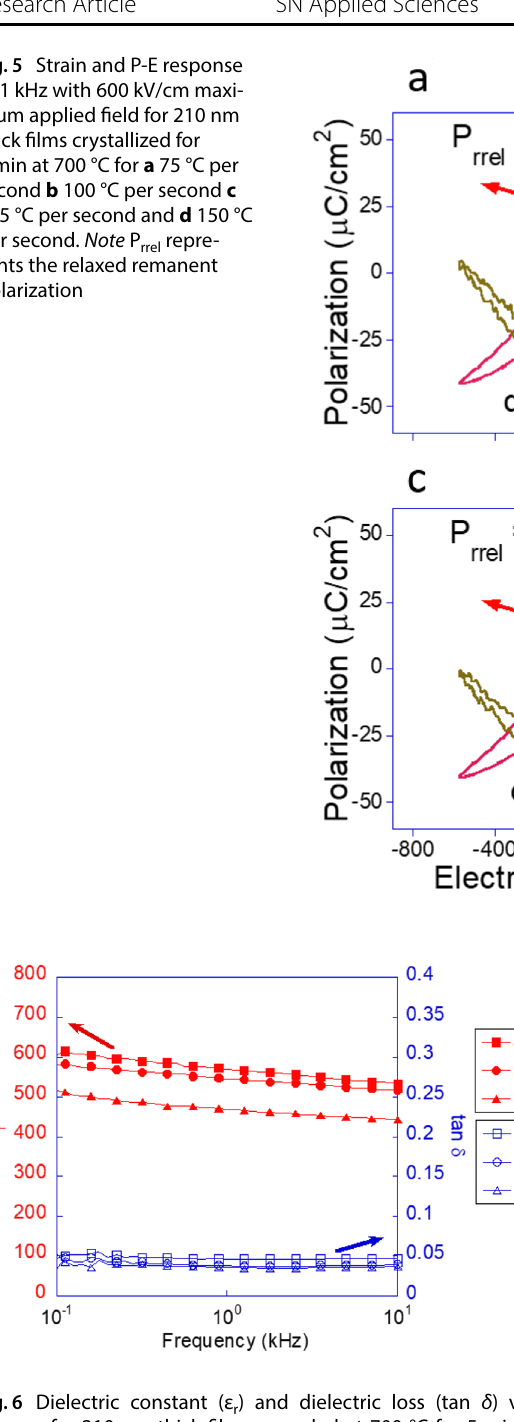
Fig. 6 Dielectric constant (ε ) and dielectric loss (tan δ ) vs. fre- r quency for 210 nm thick films annealed at 700 °C for 5 min pyro- lyzed for 4 min at 300, 350 and 400